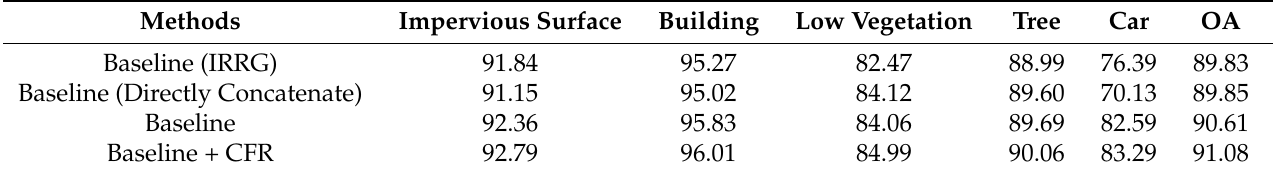
Table 1. Comparison of F1 score and overall accuracy on ISPRS Vaihingen dataset.